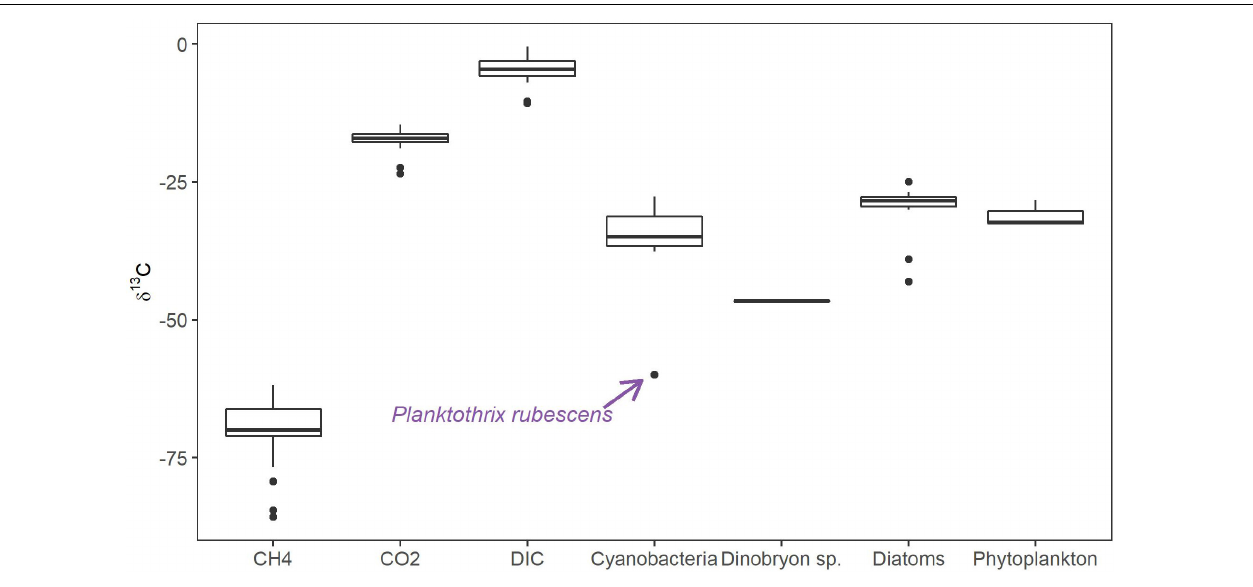
FIGURE 1 | Median values of stable carbon isotope signatures ( δ 13 C) of different phytoplankton groups and carbon sources in the sampled lakes during the 2017–2018 monitoring program. Bold horizontal line represents the median values, boxes represent 25th to 75th percentiles, and dots represent outliers.